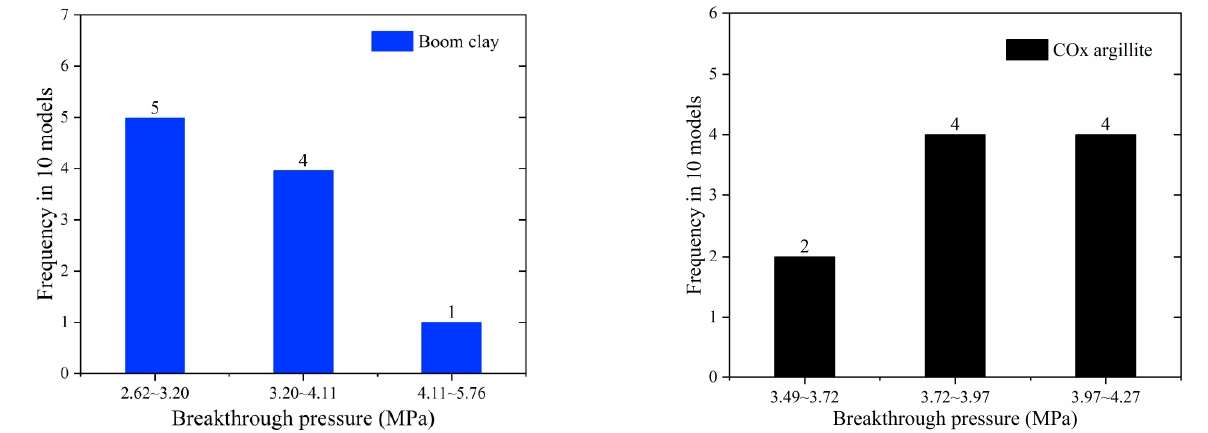
Figure 17. Numerical estimation of the gas breakthrough pressure for 10 models with the same generation parameters.